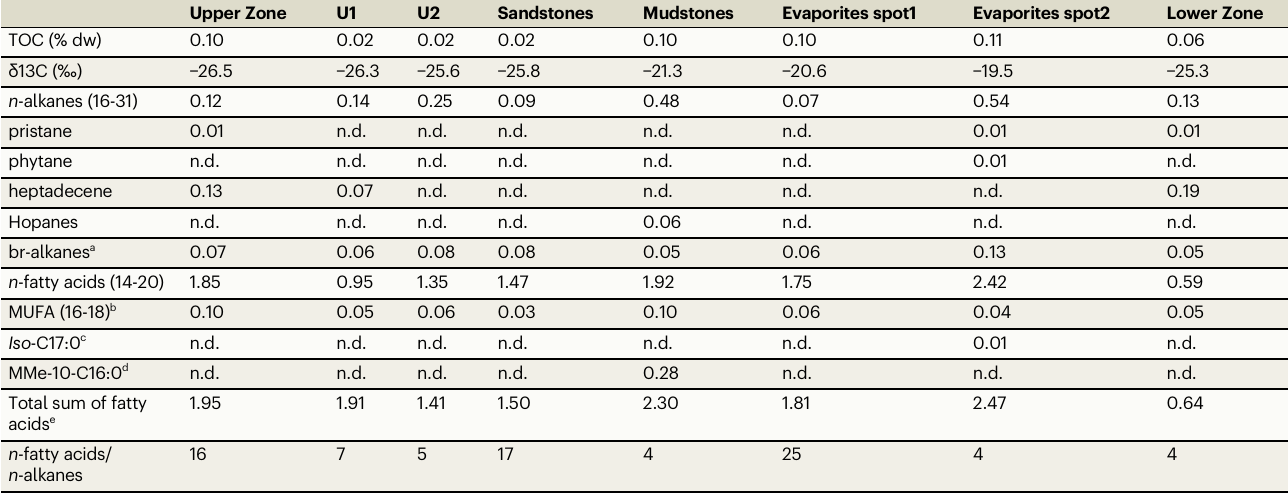
Lipidconcentrationwasobtainedbyintegratingthepeakareasofeachcompoundandapplyingtheresponsefactorofdeuteratedanalogs(tetracosane-D 50 intheapolarfractionandmyristicacid- D 27 intheacidicfraction)ofknownconcentrationaddedtothesamplepriortoextraction.Therangeofcarbonnumbersisindicatedinbracketsforthestraightchainor acids,as well as forthe monounsaturated fatty acids (MUFA). n.d.:not detected, a Sum ofbranchedalkanes, in particular monomethyl alkanes of16, 18and20carbons, b Sum ofmonounsaturated fattyacidsfrom16to18carbons, c Hexadecanoicacid,